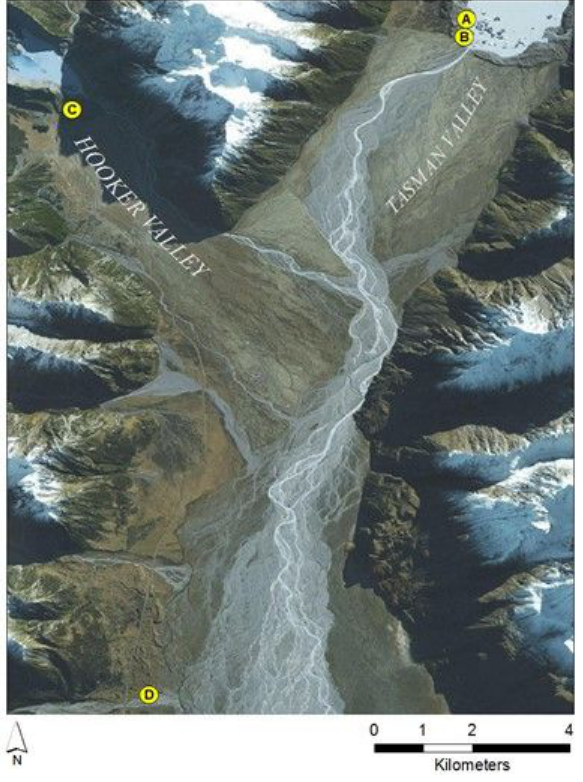
Figure 1: Location of